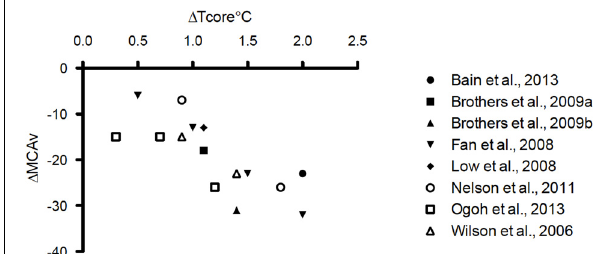
FIGURE 1 | Representation of the reported percent reductions in middle cerebral artery blood velocity (MCAv) (x axis) as a function of delta core temperature (esophageal, gastrointestinal, or rectal) (y axis) during supine passive hyperthermia up to + 2 ◦